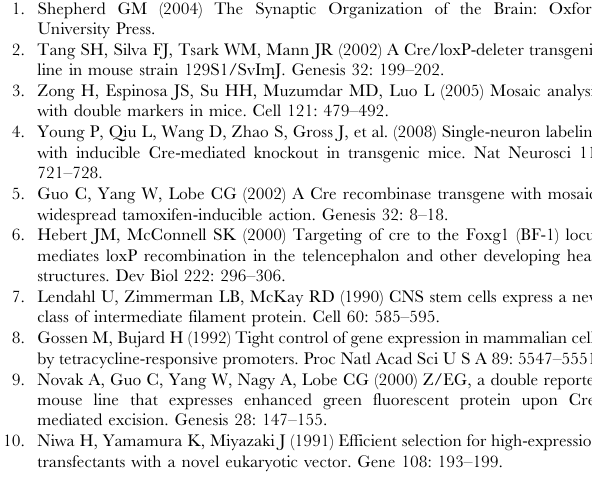
Figure S1 (A) A summary of expression data for all TRE-Bi-SG- T mouse lines generated in this study. INS 2 , without insulators; INS + , with insulators. (B) The transgene copy number for the two TRE-Bi-SG-T mouse lines determined by quantitative PCR [71]. GT: an unpublished knock-in mouse line that carries a single copy of GFP and tdT; TT: an unpublished knock-in mouse line that carries two copies of tdT. Figure S2 Statistics of the distributions of inter-puncta distances in the granule cells axons. (A) A bar graph showing coefficients of variation (CV =SD/mean) of presynaptic densities for all sample groups. Groups are labeled on the X-axis and the CV values on the Y-axis. The density of synapses on the GC ascending segment below and within the PC layer is highly variable between cells (CV between 0.6 and 1.3), while the density of synapses in the GC ascending segments above the PC layer and in parallel fibers is more consistent between cells (CV , 0.2). (B–D) Histograms of the distribution of inter-puncta distances in the ascending segment below and within the PC layer (B), above the PC layer (C) and in parallel fibers (D). The P-value of GOF (Goodness of Fit) is generated by the Chi-Squared test. Two distributions best fit a Burr (4P) distribution (red line) and the other one best fits an